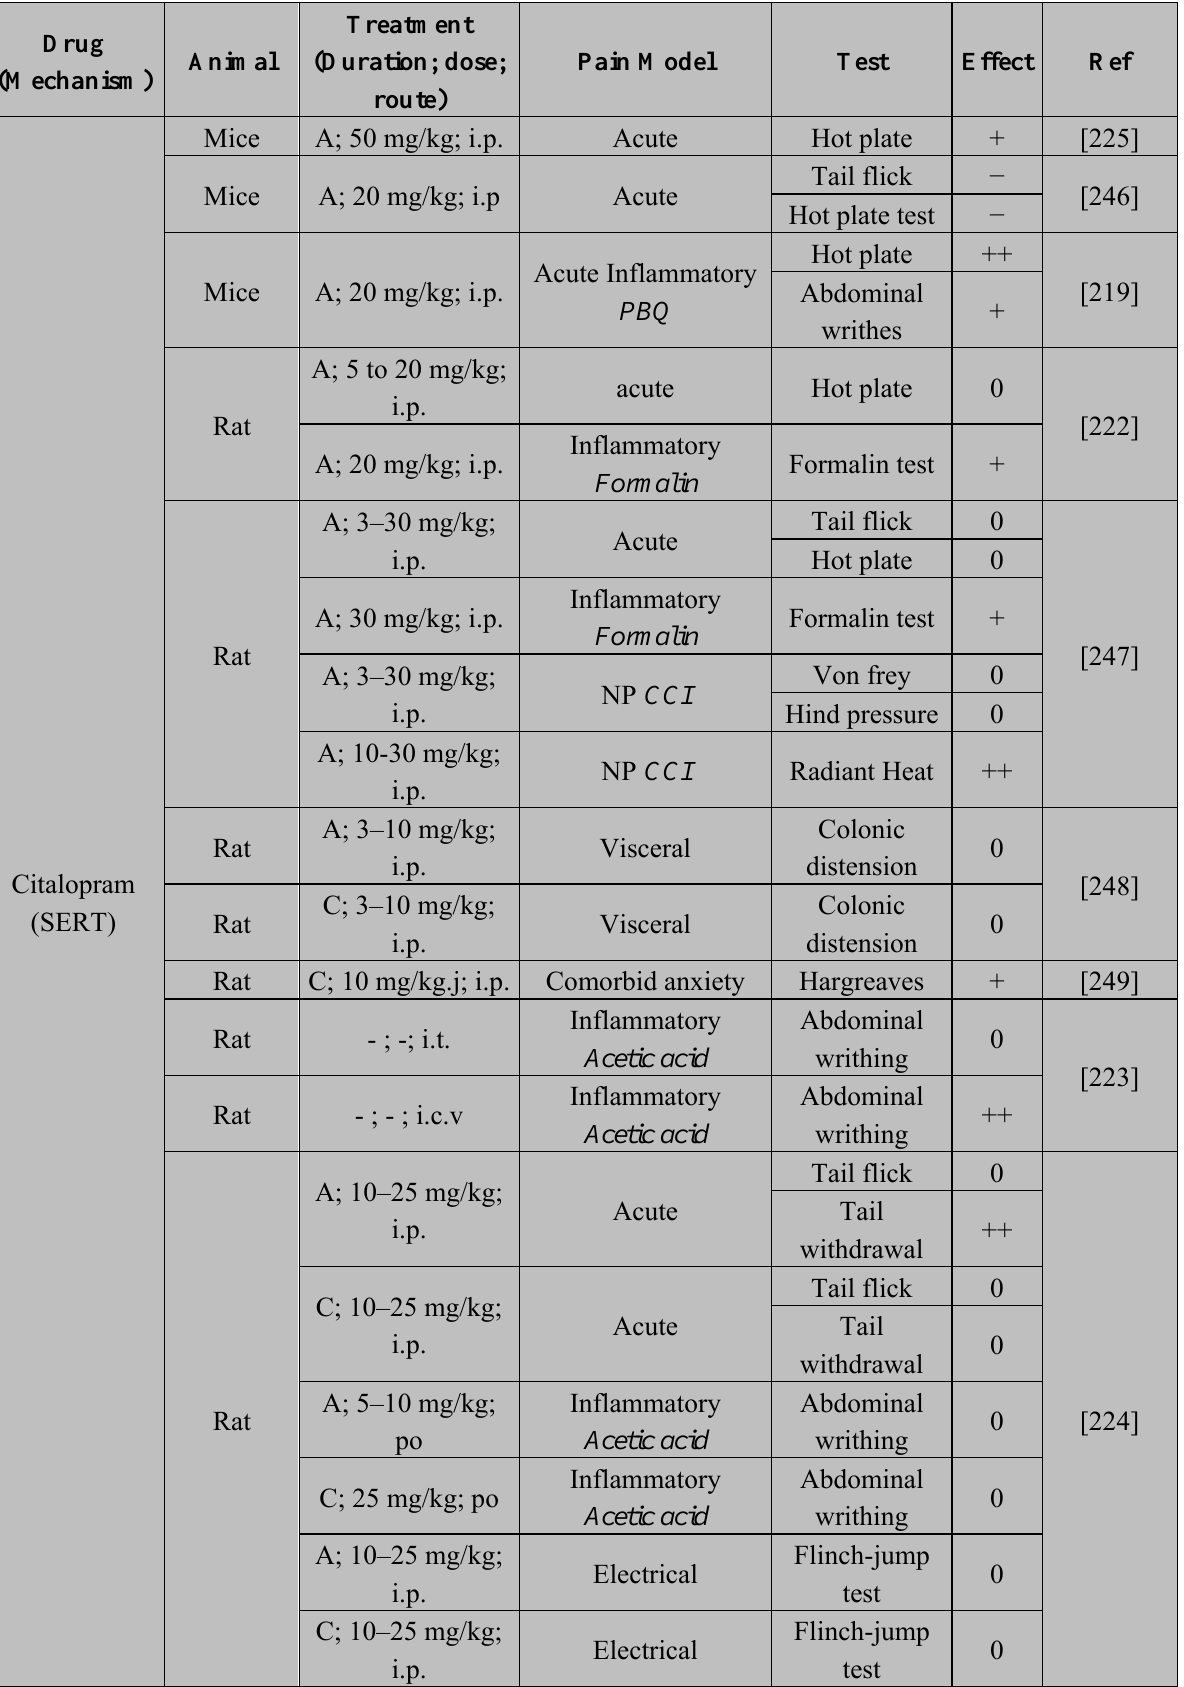
Table 3. Effects of monoaminergic reuptake inhibitors on different models of acute and chronic pain in